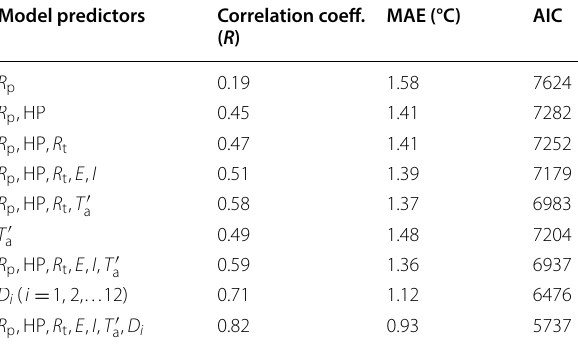
Table 2 Indicator metrics for models with different candidate predictors in the stepwise regression procedure (refer to “Modeling temperature-hydropower